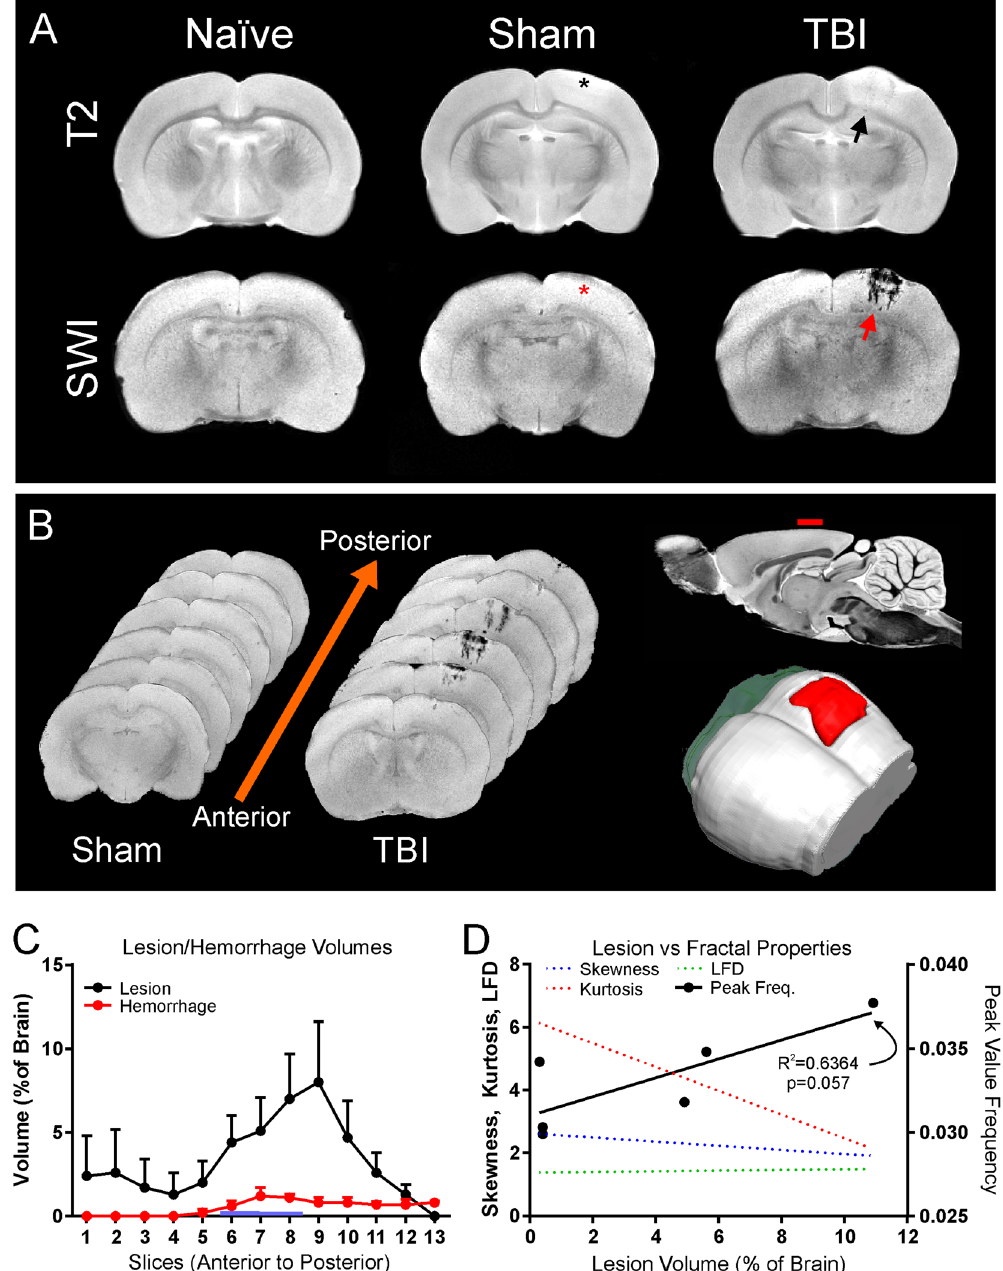
Figure 6. Magnetic Resonance Imaging (MRI) of lesion and hemorrhage volumes in vessel painted brains. ( A ) Representative coronal slices from naïve, sham, and TBI animals at 1d post injury. T2 Weighted Imaging (T2WI) was performed for lesion (blood and edema) volumes while Susceptibility Weighted Imaging (SWI) was used to derive hemorrhage volumes (top and bottom row respectively). Note that the SWI vividly demonstrates hemorrhage in the TBI animal (red arrow) in comparison to the T2WI. Note the lack of bleeding at the craniotomy site in shams (asterisk). ( B ) Coronal SWI images in an anterior to posterior progression from a sham and TBI animal illustrating the anterior-posterior extent of lesion hemorrhage through the cortex (left). Sagittal view of MRI with red dash indicates the site of injury (top-right). A three-dimensional reconstruction from SWI data set shows the expanse of hemorrhage (red, bottom-right). ( C ) Automated lesion and hemorrhage analysis (hierarchical region splitting, HRS) was used to determine the group average from all TBI animals. Edema constituted the largest component of the lesion at 1d after injury. Lesion and hemorrhage volumes were significantly higher in TBI animals when compared to naïve and sham groups (p < 0.05). ( D ) Correlations were performed to determine if individual fractal properties were more predictive of vascular loss and how these were related TBI lesions. Only the fractal peak value correlated to the extent of lesion and approached significance (r 2 = 0.6364, p = 0.057) but no significance was found for fractal kurtosis (p = 0.093), skewness (p = 0.095) or LFD (p =